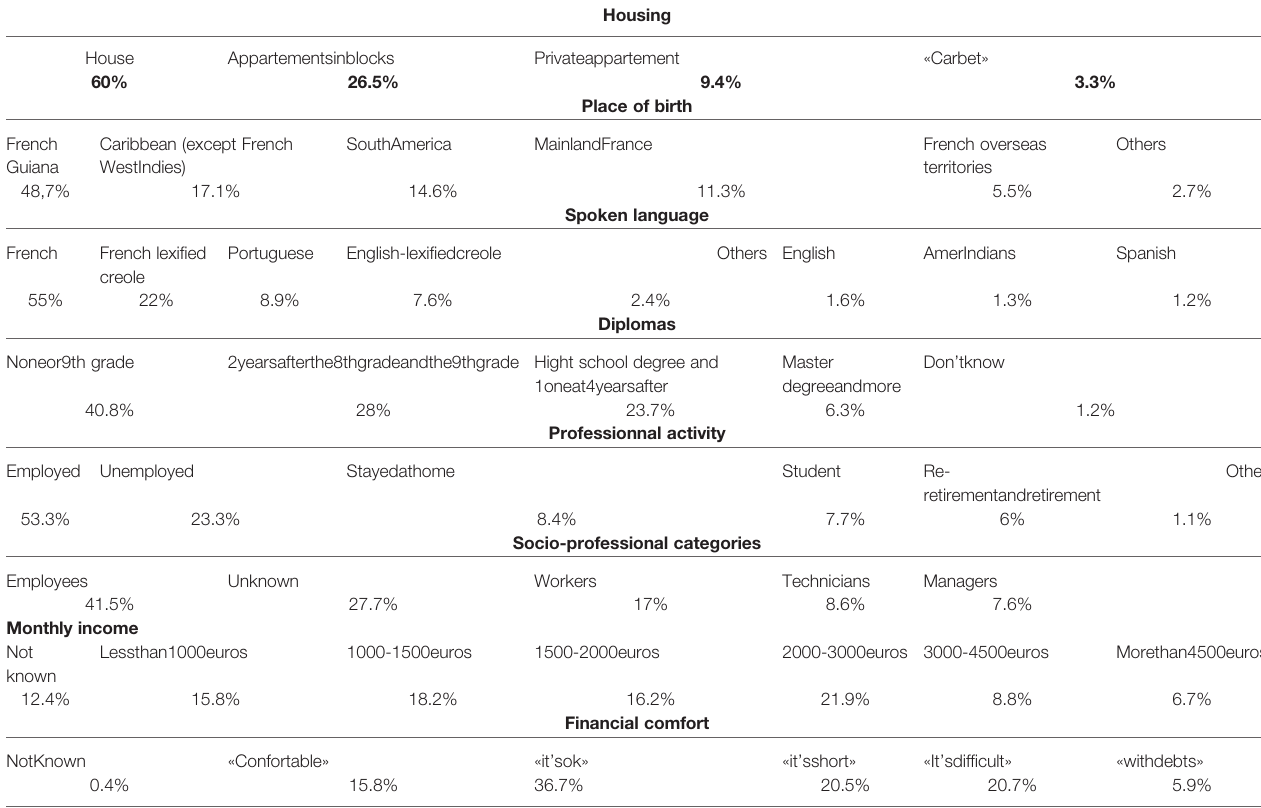
TABLE 3 | Description of binary socioeconomic factors.